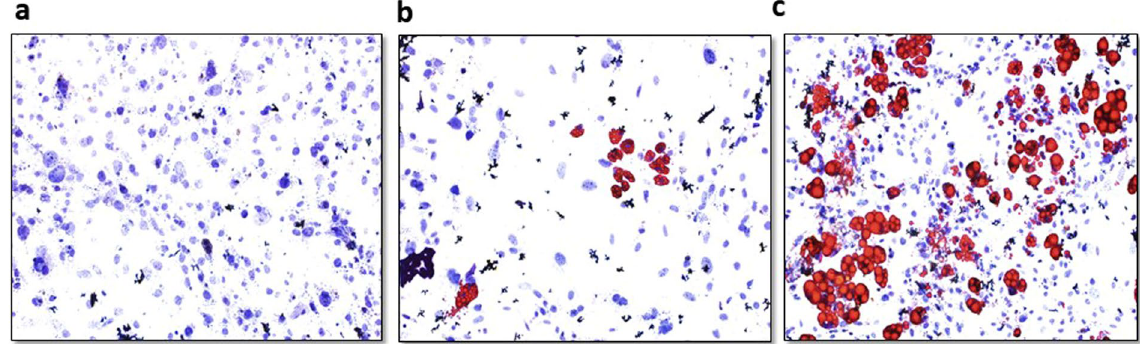
Figure 1. Oil Red O staining of differentiated human preadipocytes. ( a ) Undifferentiated human preadipocytes, 4 weeks after culturing without induction media. ( b ) Differentiating human preadipocytes with tiny lipid droplets 2 weeks after induction of differentiation. ( c ) Differentiated human preadipocytes 4 weeks after induction of differentiation with large formed lipid